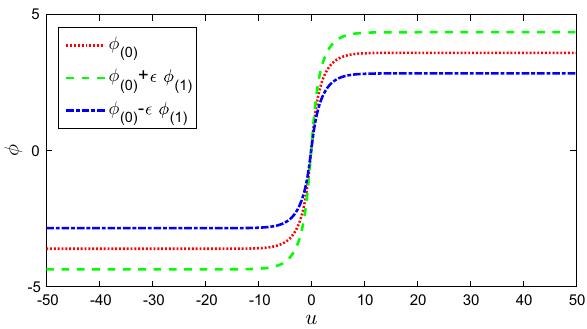
Fig. 13 Plot of the scalar field φ and its first order correction, for the parameter values (cid:9) = 0 . 15, c = 0 . 5 and s =